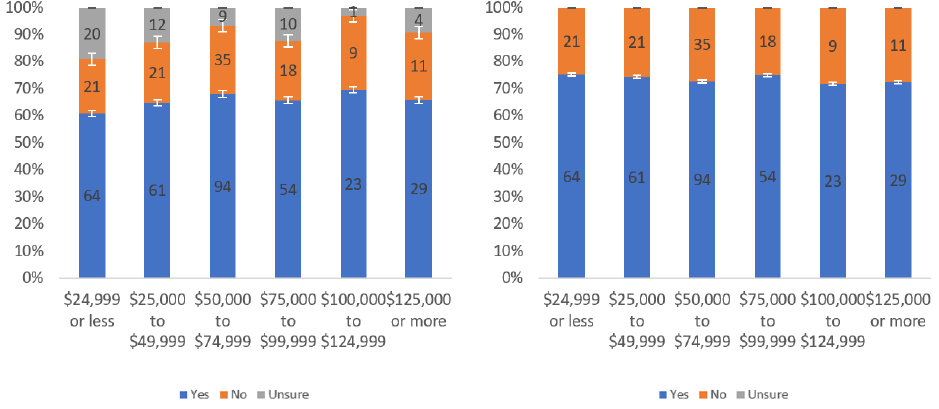
Figure 13. Responses regarding respondents’ willingness to review by income level including ( left )